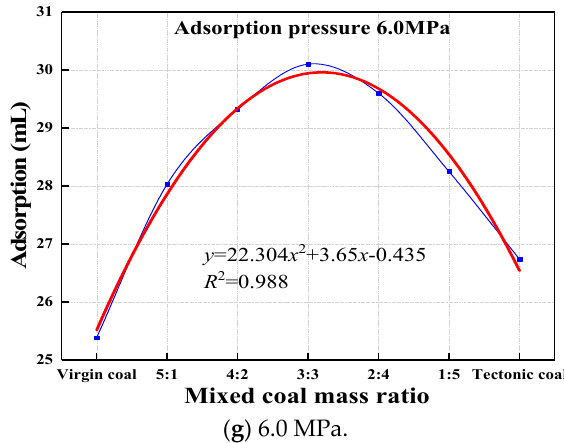
Figure 4. Adsorption quantity with different mass ratios of mixed coal at the same pressure: ( a ) adsorption pressure 1.2 MPa, y = 6.806x 2 + 0.551x − 0.064; ( b ) adsorption pressure 2 MPa, y = 13.378x 2